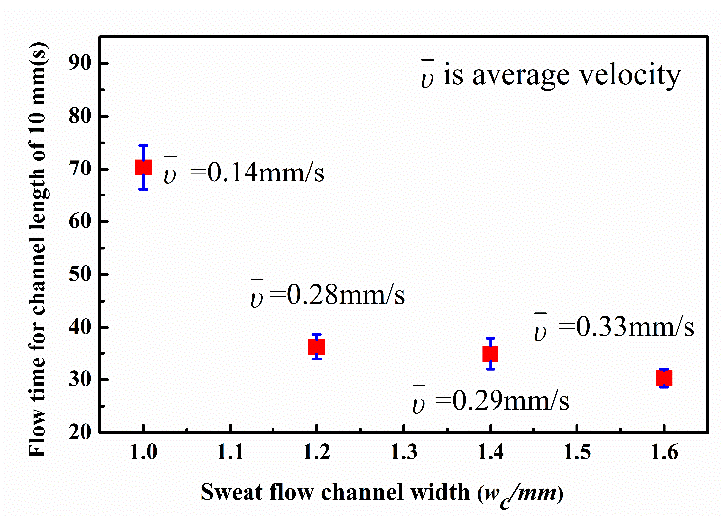
Figure 6. Recordings illustrating the process of sweat flow in a paper-based wax channel with a width of 1.2 mm and displacement of 10 mm.